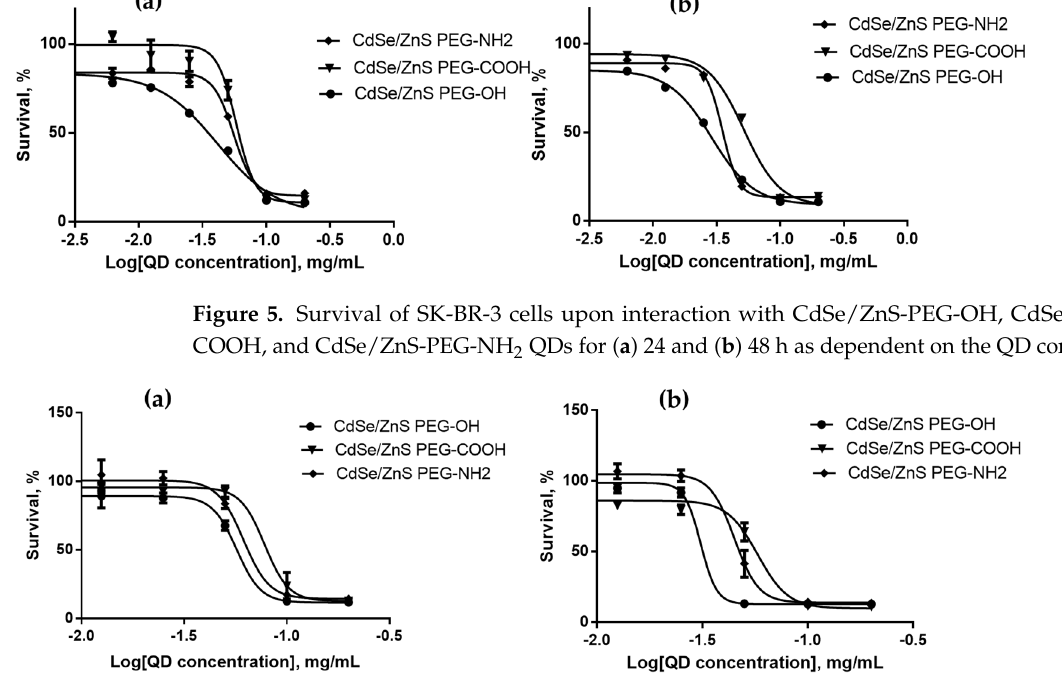
Figure 6. Survival of Wi-38 cells upon interaction with CdSe/ZnS-PEG-OH, CdSe/ZnS-PEG-COOH, and CdSe/ZnS-PEG-NH 2 QDs for ( a ) 24 and ( b ) 48 h as dependent on the QD concentration.